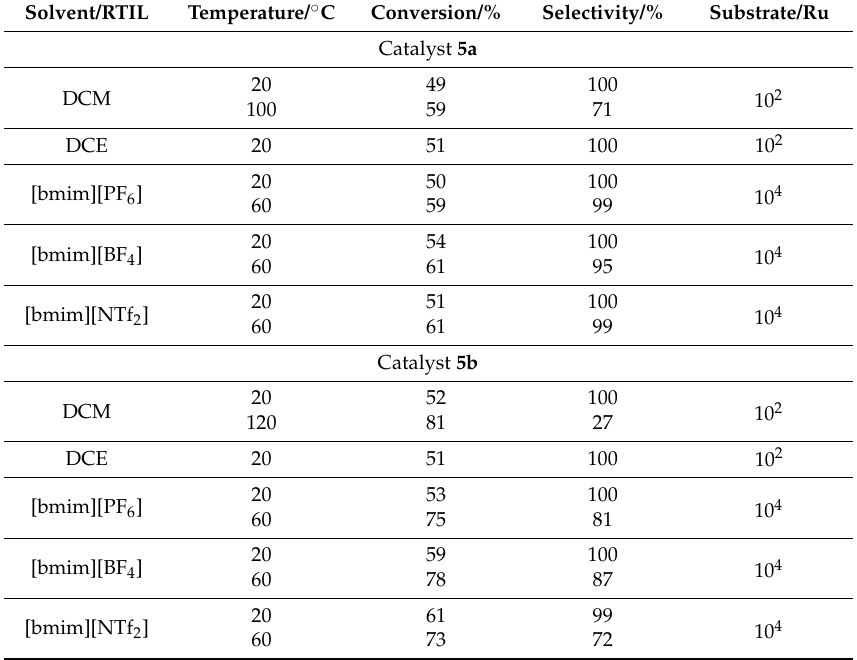
Table 1. Activity and selectivity of Grubbs catalysts 5a and 5b on methyl oleate in ILs vs. selected organic solvents.